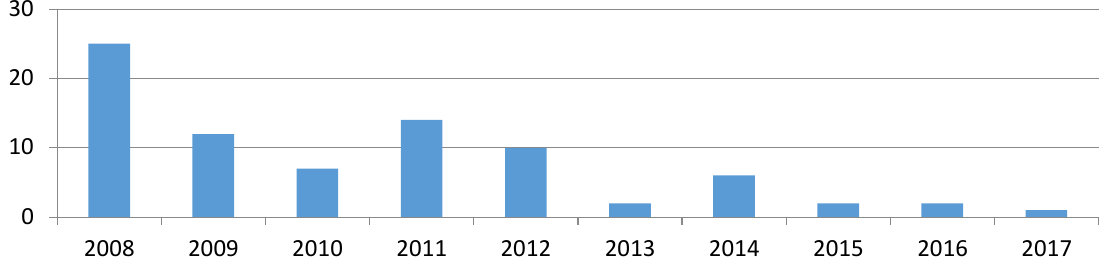
Figure 4. Frequency of overreactions: case of the UX index for the period 2008–2017 (annual data)